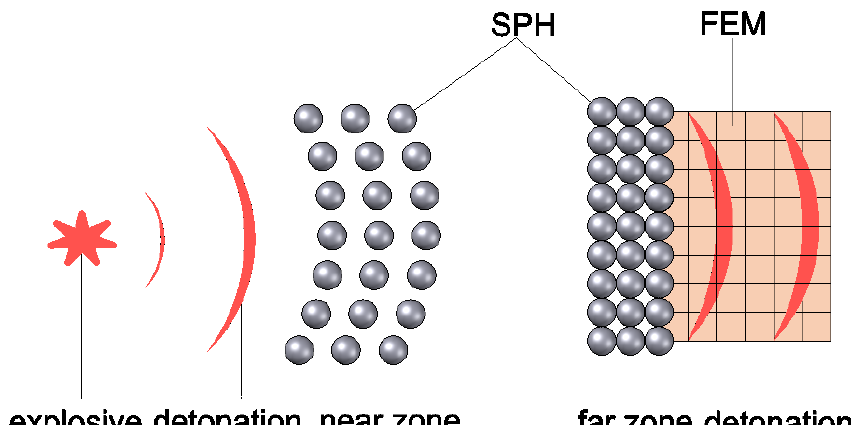
Figure 1. SPH-FEM near-field and far-field simulation.